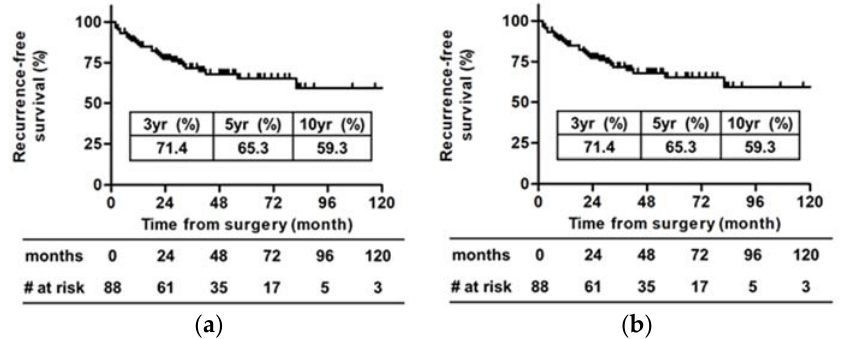
Figure 2. Recurrence-free survival and cancer-specific survival probabilities for pT3aN0M0 RCC. RFS and CSS were estimated using the Kaplan–Meier method. ( a ) The 3-, 5-, and 10-year RFS rates were 71.4%, 65.3%, and 59.3%, respectively. ( b ) The 3-, 5-, and 10-year CSS rates were 93.8%, 88.4%, and 81.1%, respectively RFS, recurrence-free survival; CSS, cancer-specific survival. There were 35 patients (38.5%) with cT1 and 16 patients (17.6%) with cT2 RCC. Seven